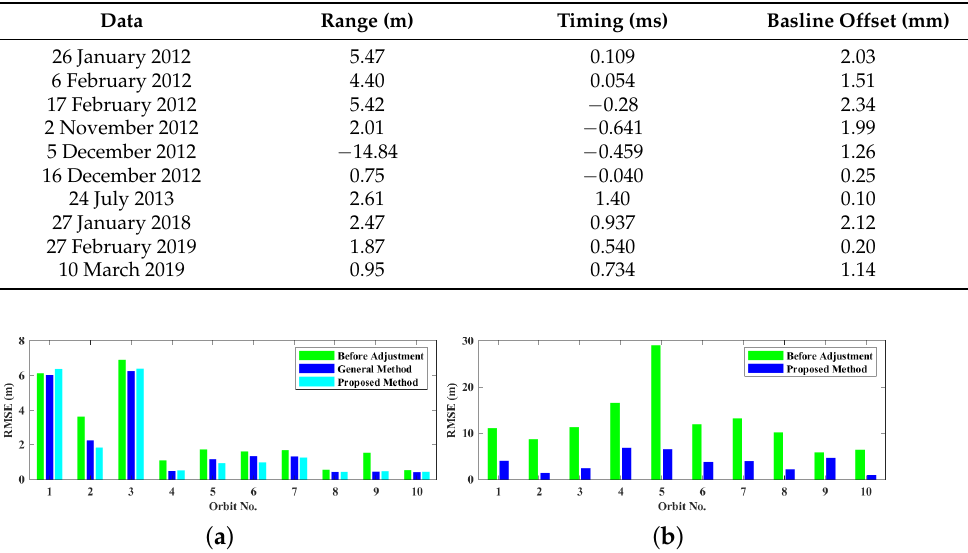
Figure 12. Statistics of ( a ) elevation and ( b ) plane accuracies before and after adjustment.